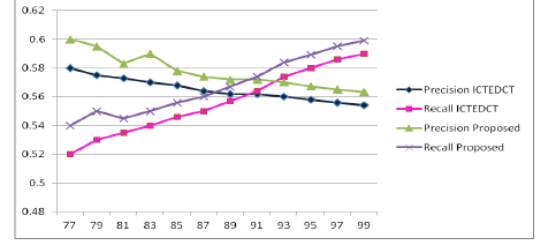
Fig. 11. Precision and Recall results on Coil dataset